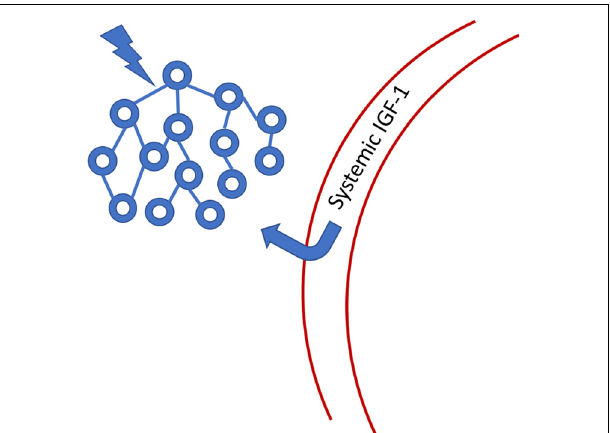
FIGURE 6 | Systemic IGF-1 is transported through the blood-brain-barrier (BBB) to the site of neuronal activity. IGF-1 binding protein is cleaved from the IGF-1 molecule, allowing passage through the barrier. Once in the CNS, IGF-1 has a limited half-life because it no longer has its binding protein chaperone. See Nishijima et al. (2016) for a more detailed